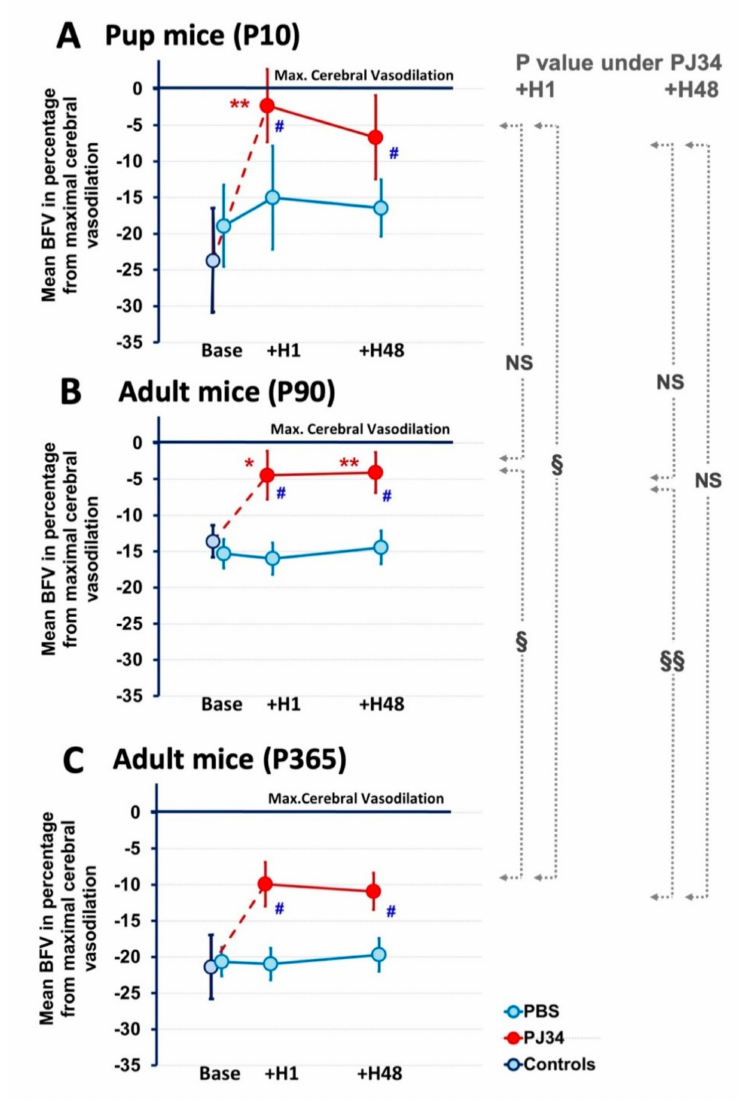
Figure 2. Vasoreactivity during development (P10 to P365) and e ff ect of PJ34 on the maximal cerebral vasodilation in P10 ( A ), P90 ( B ) and P365 ( C ) mice. Data are represented as mean blood flow velocities (mBFVs) related to the maximal cerebral vasodilation under CO 2 in basal (control-naive and PBS-treated) P10, P90, and P365 mice and 1 and 48 h after PJ34 administration. PJ34 induced a recruitment on the cerebral vasodilation reserve at each stage of development. At P365, the PJ34 vasodilator e ff ect was lowered compared to P10 and P90. (* p < 0.005, ** p < 0.001 vs. basal, # p < 0.005, vs. PBS, § p < 0.005, §§ p < 0.001 PJ34 at + H1 or at + H48 between ages, NS : not